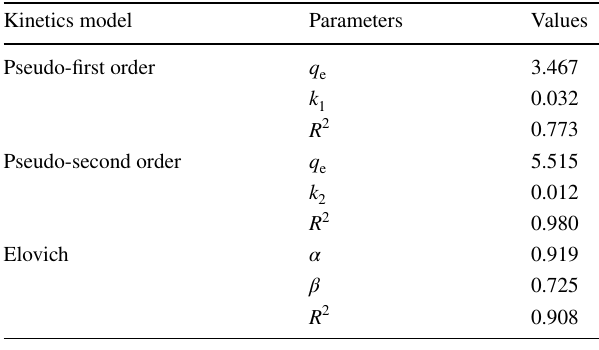
Table 3 Kinetics parameters